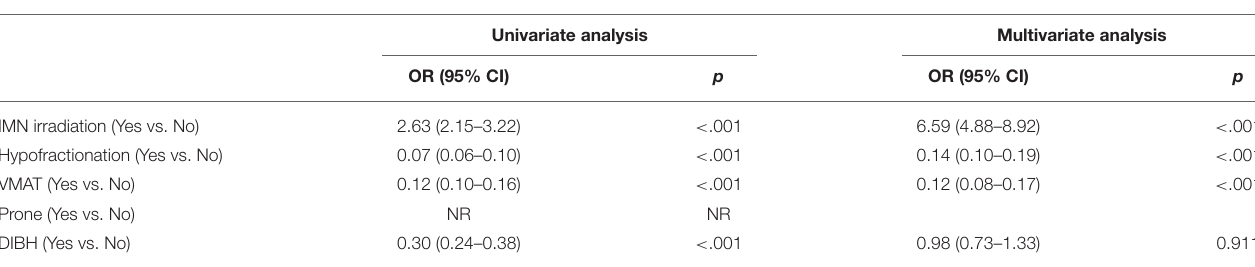
TABLE 4 | Analysis the factor determining the lung V 30